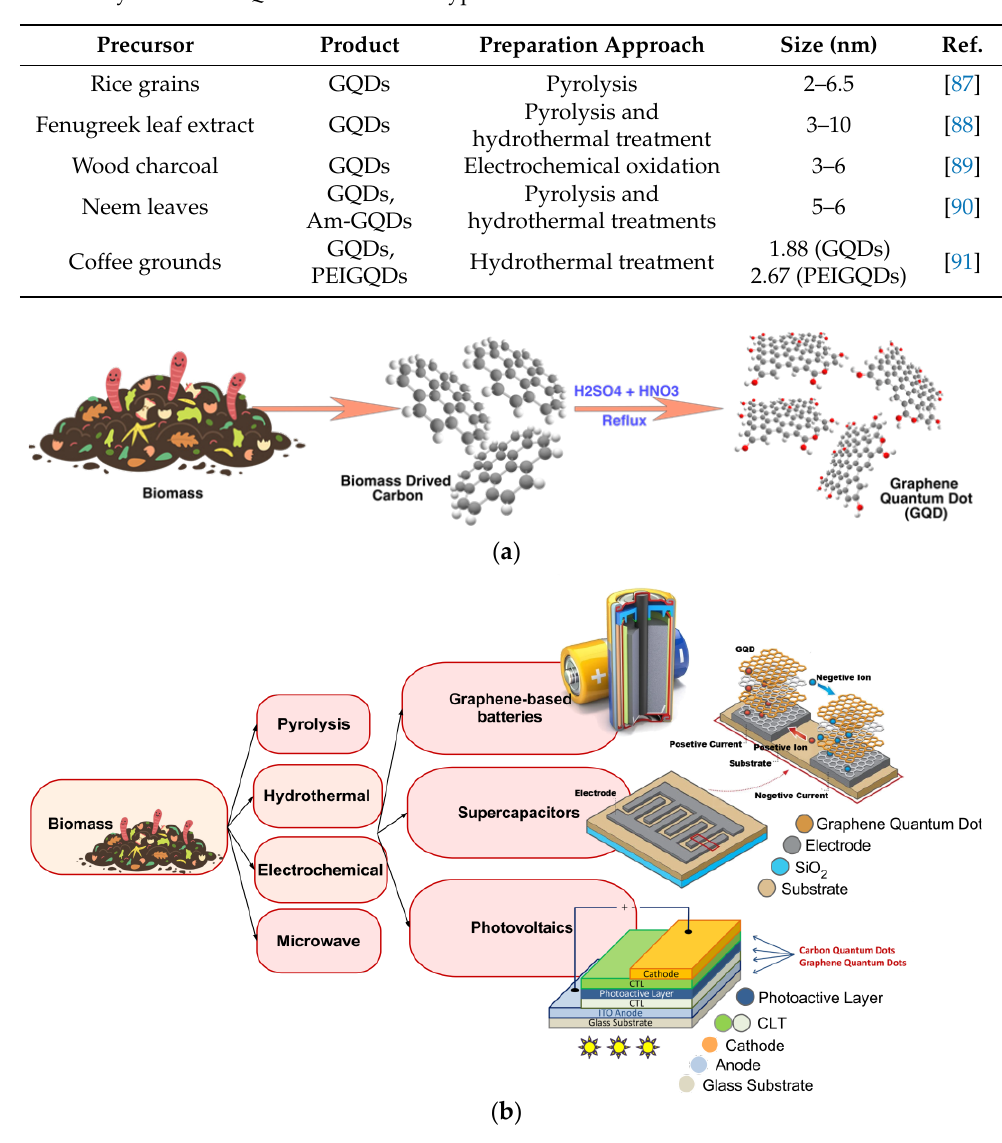
Figure 3. ( a ) The synthesis of GQD (C 57 H 26 O 11 ) from different types of biomass-waste; ( b ) figure illustrates the various approaches used for converting biowaste into GQDs, along with how they can be used as energy sources. Table 2. Synthesis of GQDs from different types of biomass-waste.